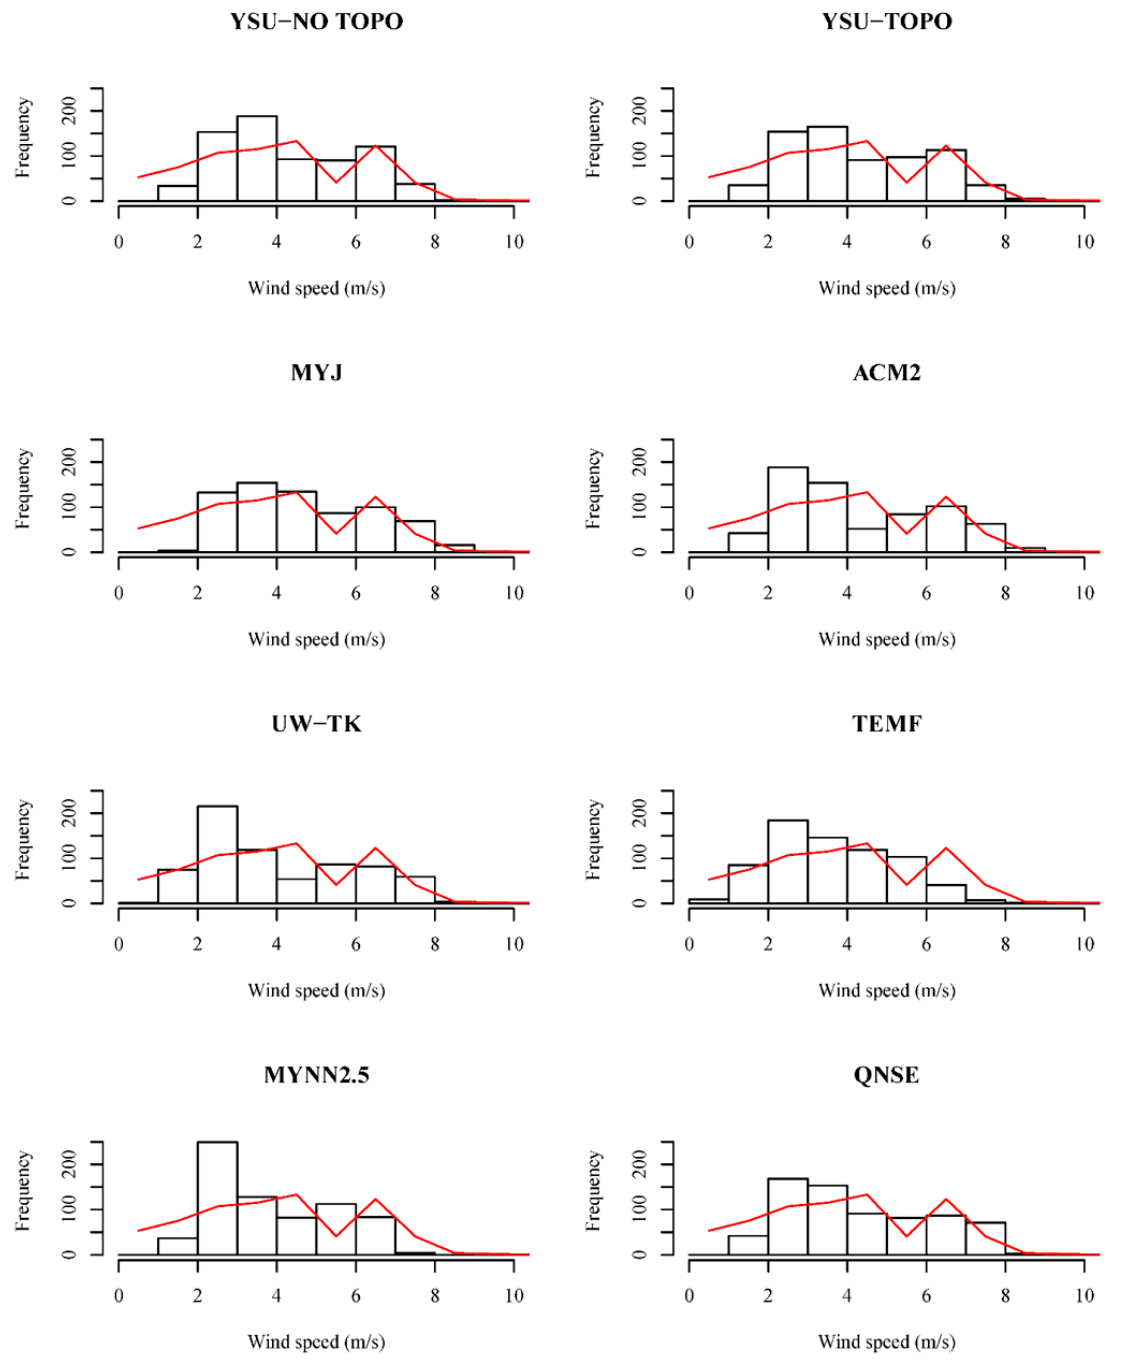
Figure 17. Histograms of simulated 10 m level wind speeds at Piarco for April 2003. The red line denotes the observed wind speed histogram for April 2003.